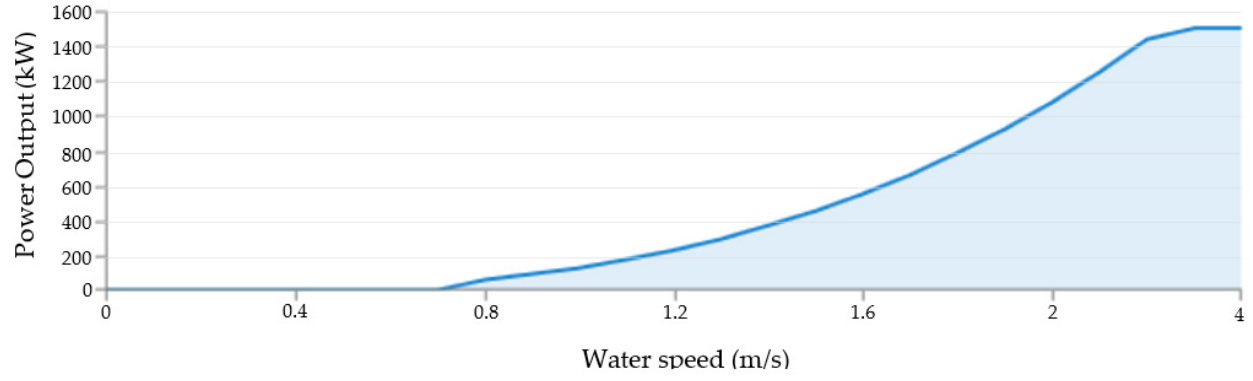
Figure 10. Hydrokinetic turbine power curve.